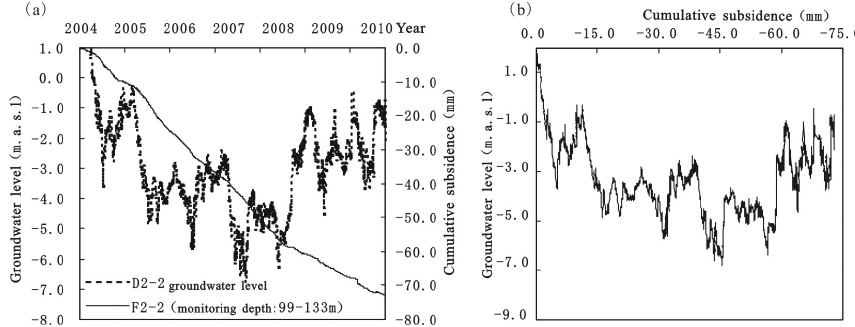
Figure 5. Deformation behavior of the deep soil mass vs. its corresponding groundwater level at layered mark F2-2. (a) Groundwater level and deformation over time, (b) groundwater level vs. deformation hysteresis